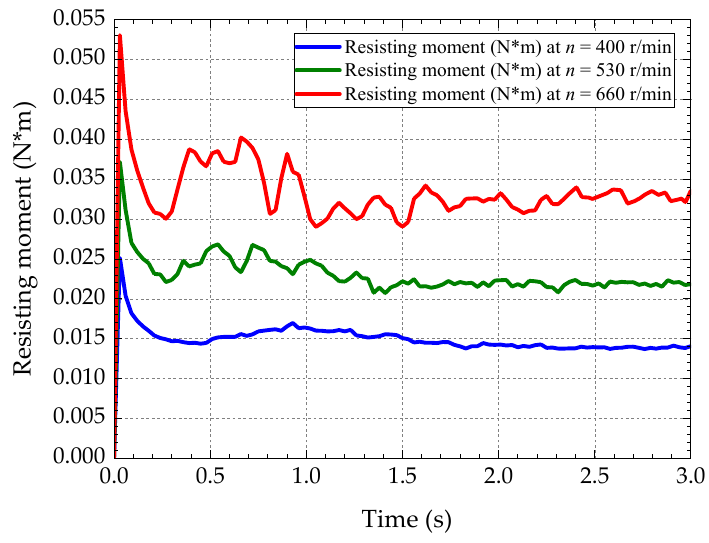
Figure 5. Fluid resisting moment–time curve.